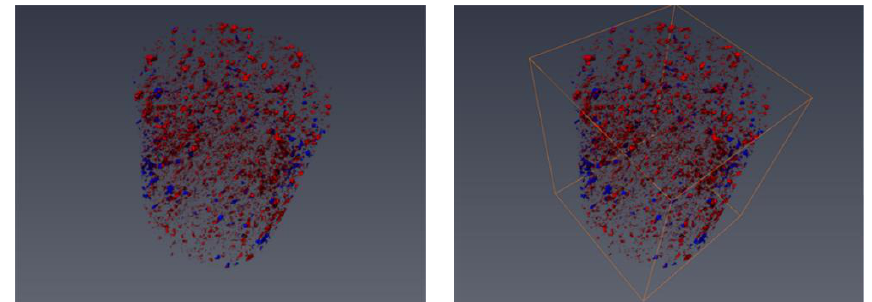
Figure 5. CT diagram of the saturated oil sample (blue is the irreducible water and red is oil).